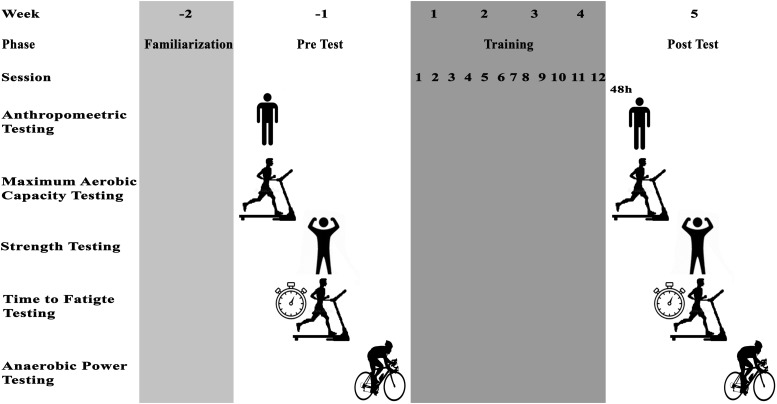
Schematic overview of study timeline.